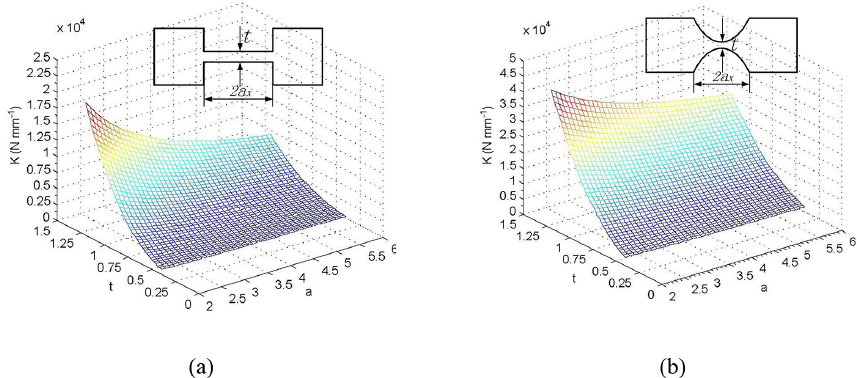
Figure 3. Different types of single DOF flexure hinge and its rotational stiffness with t and a x . (a) leaf spring flexure and its rotational stiffness; (b) right circular cut flexure and its rotational stiffness.